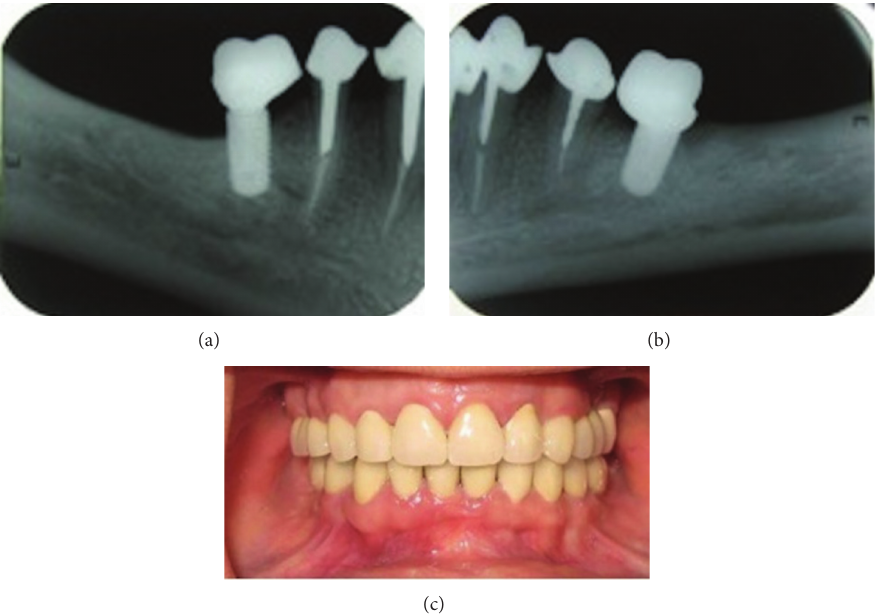
Figure 7: Intraoral view and periapical radiographies of implants after one-year